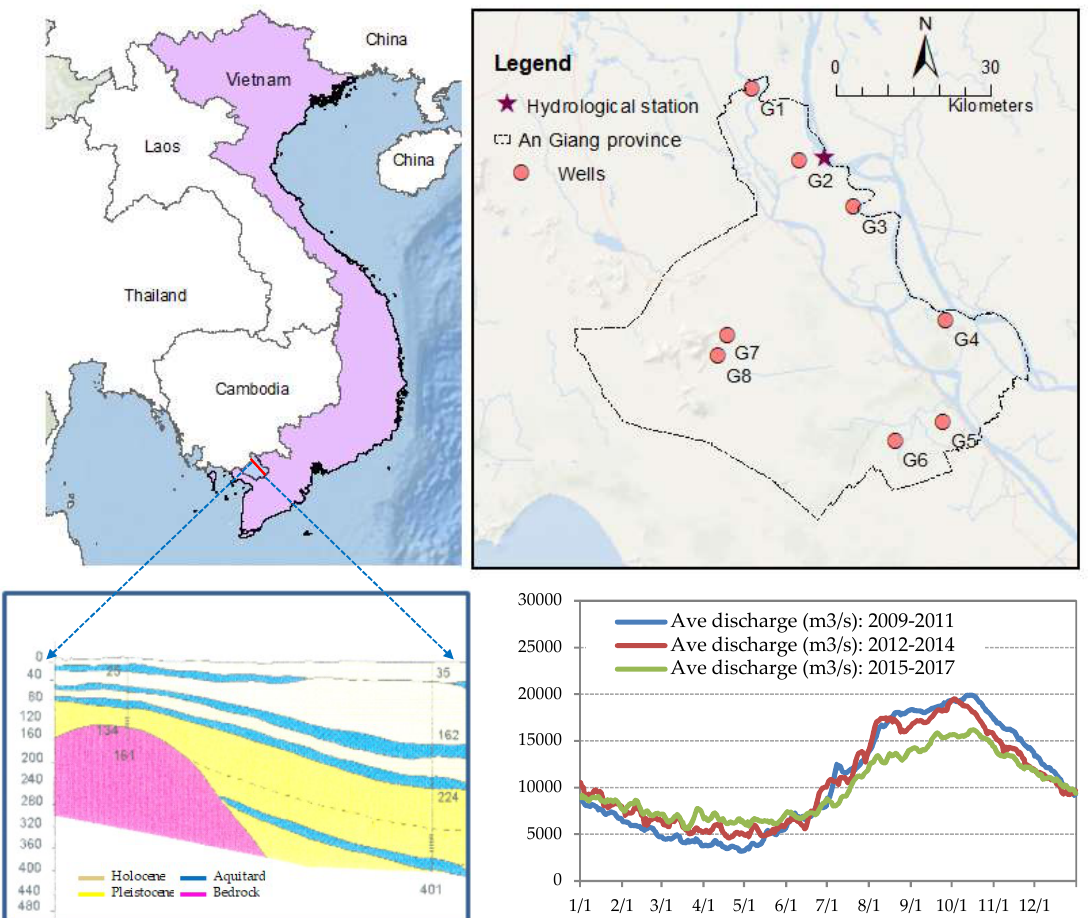
Figure 1. Study area map with the location of monitoring wells and Tan Chau hydrological station on Mekong River. Discharge data were collected from the Southern Regional Hydrometeorology Center in Vietnam, during 2009 – 2017. The geological data were collected from the Southern Geological Division geohydrology and Engineering Geology.